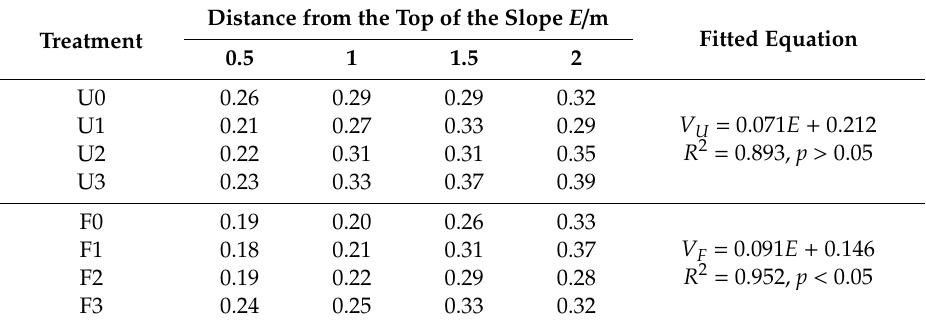
Fitted Equation